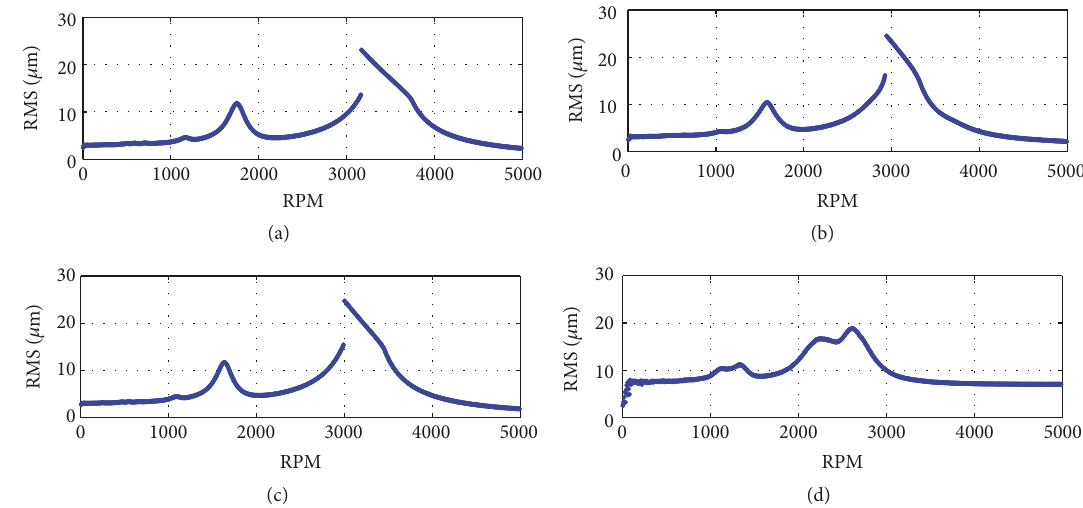
Figure 7: RMS of DTE obtained by using the different STE curves computed for the four gear pairs shown in Figure 1.